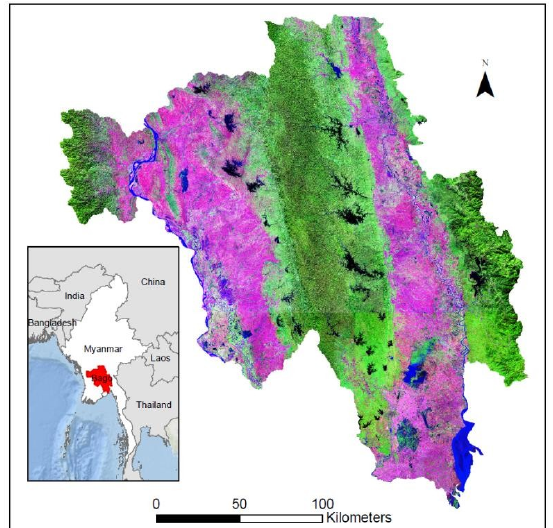
Figure 1. Location of the study area. The Sentinel-2 image in false color composite RGB: 11, 8, 3 band combination shows the distribution of the forests (green) in the study area.